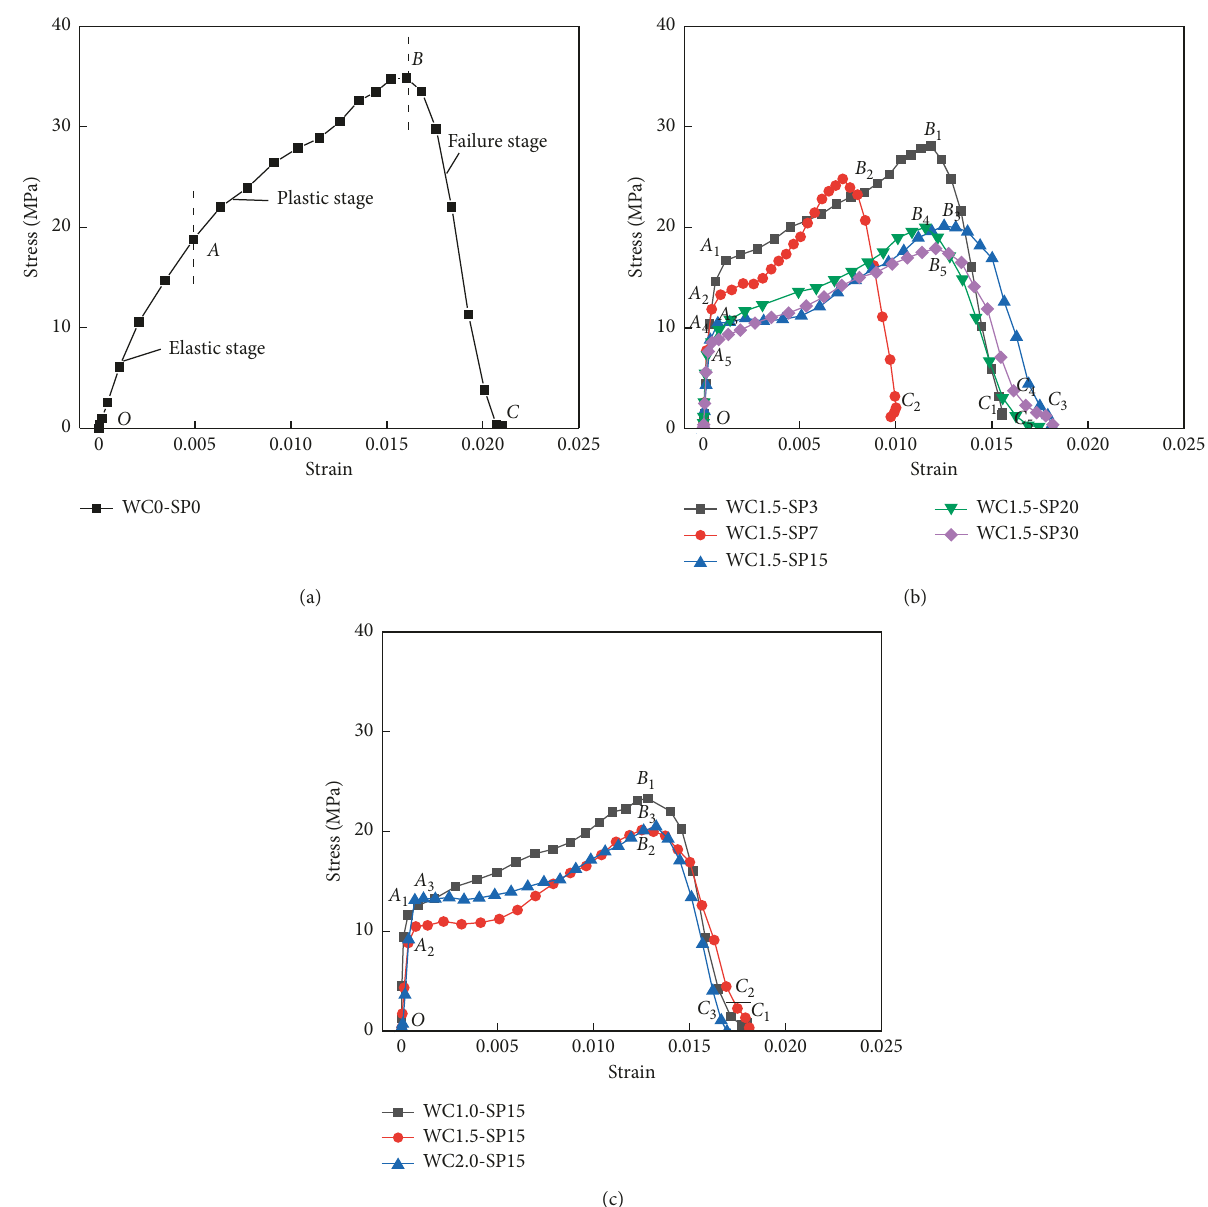
Figure 9: Dynamic stress-strain curves for ready-mixed concrete with 0.6MPa impact pressure in uniaxial load